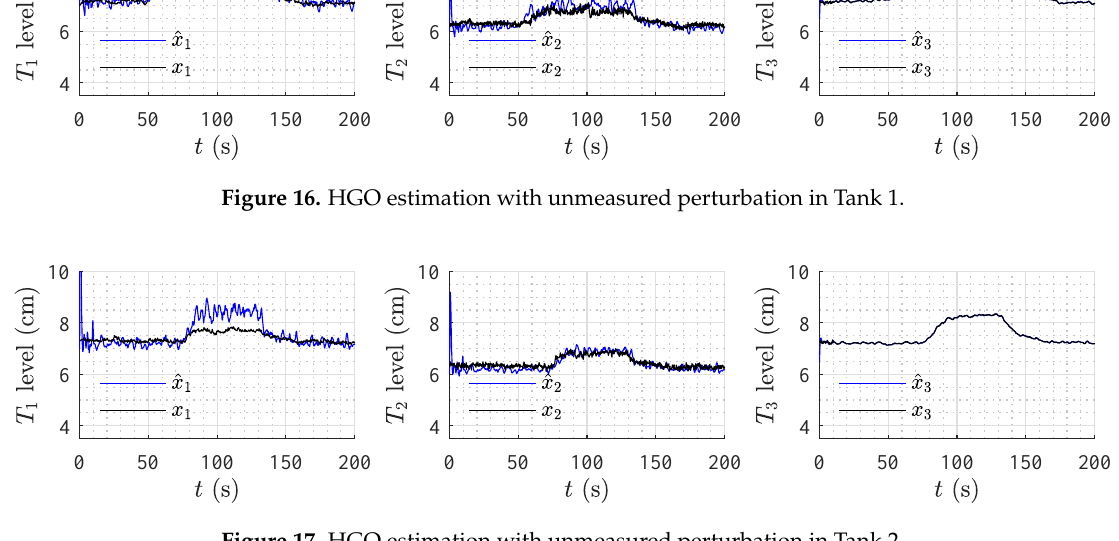
Figure 17. HGO estimation with unmeasured perturbation in Tank